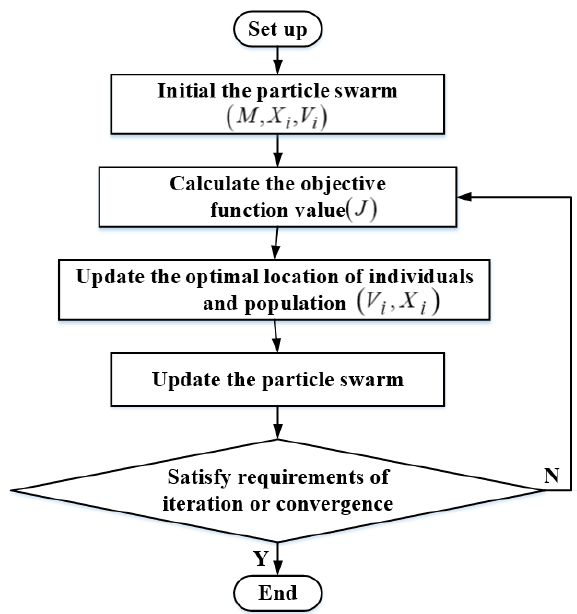
Figure 12. The flow chart of the PSO algorithm.